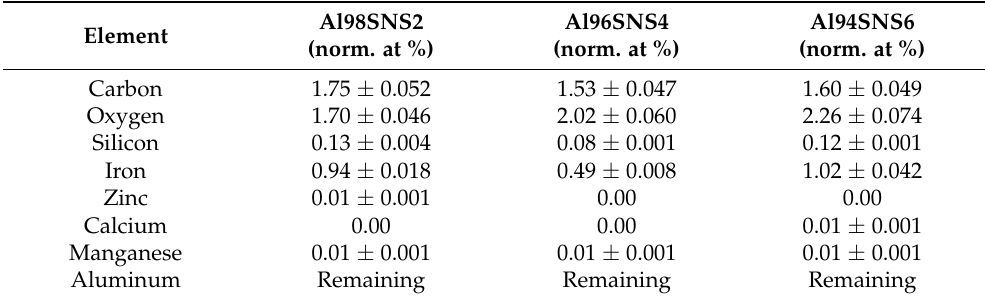
Table 8. EDS—elemental composition results after corrosion (Weight %); (the calculated SD is averaged from 10 measurements, 5 on each of the 2 replicates).